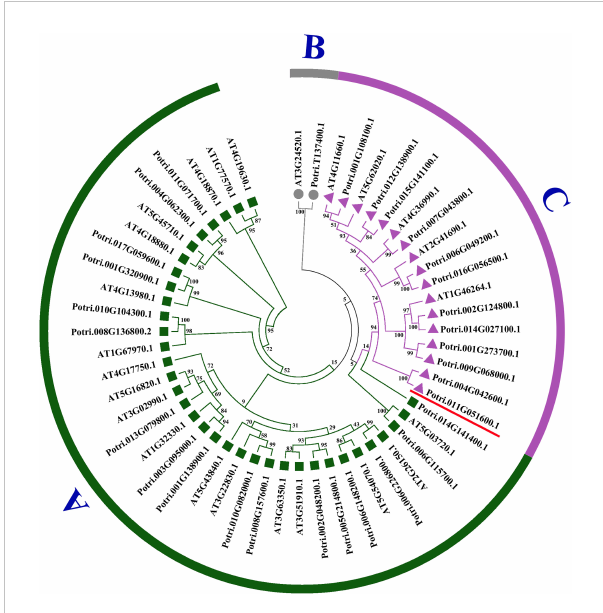
FIGURE 2 Phylogenetic tree of PtHSFs and AtHSFs. The rootless phylogenetic tree of the HSF protein sequence of poplar and Arabidopsis thaliana was drawn by the NJ neighbor method in MEGA7.0. The phylogenetic tree was divided into three groups: (A – C) , with each color remaining in one group. Potri.011G051600.1 (PtHSF21) was marked with a red “– . ”